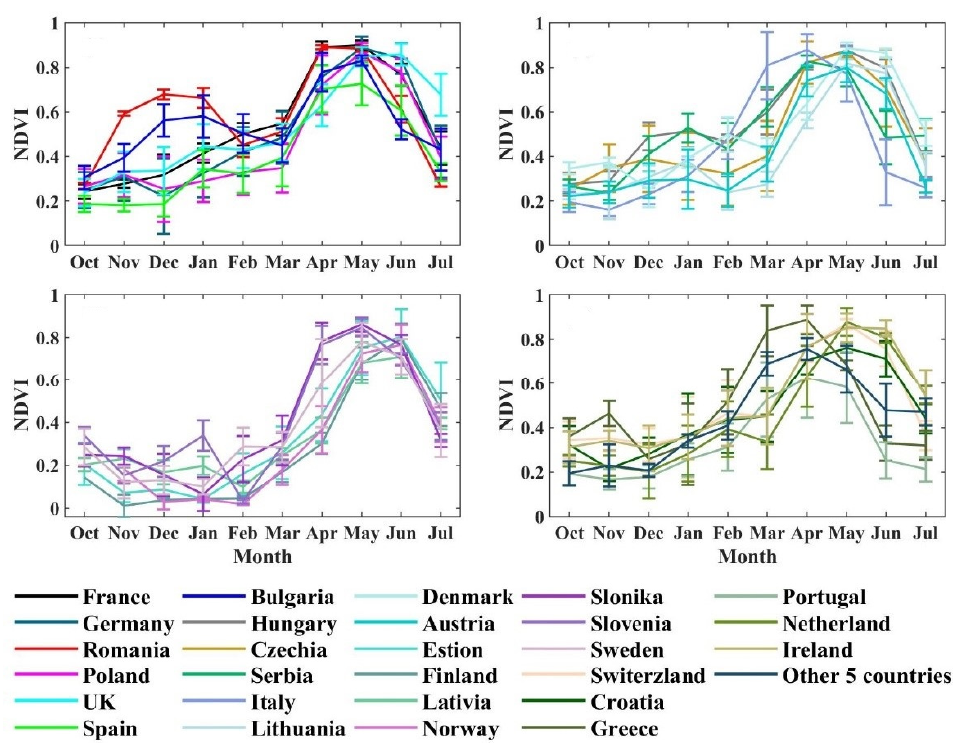
Figure 3. The standard NDVI seasonal change curves of winter cereals in 32 countries in Europe. Error bars are standard deviations. The other five countries are Albania, Bosnia-Herzegovina, Kosovo, Macedonia, and Montenegro. In this study, we used the same standard curve for these latter countries because they are geographically adjacent.